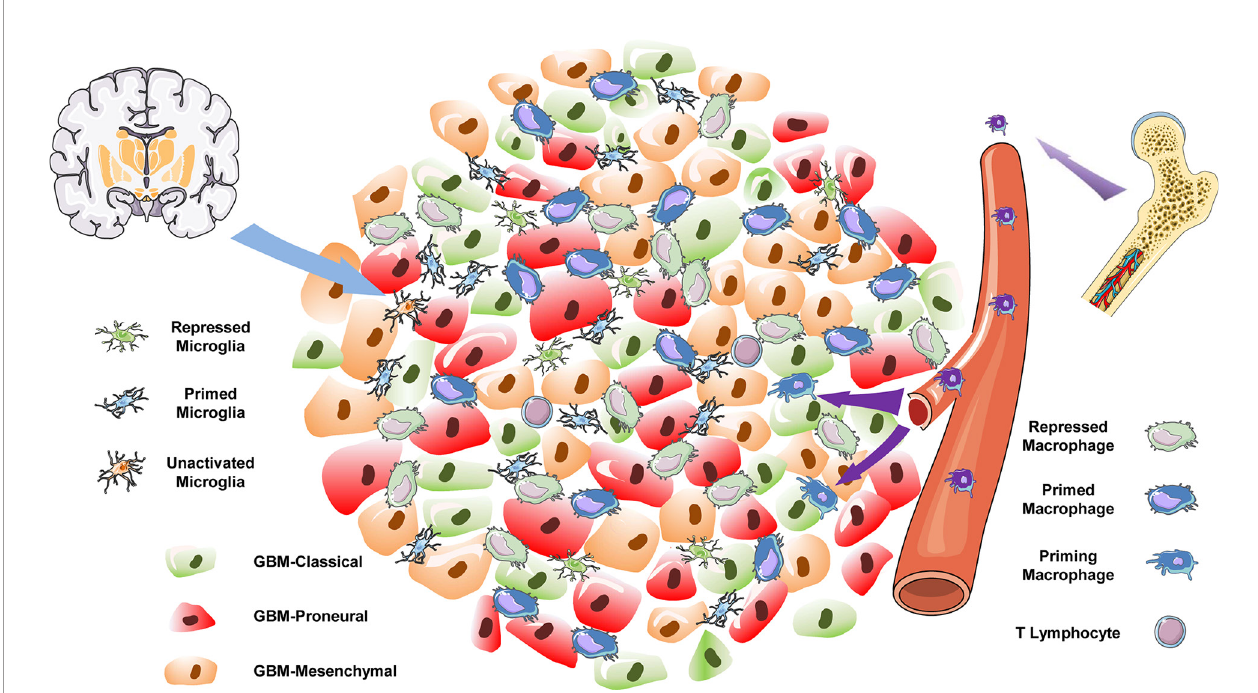
FIGURE 7 | The immune landscape of